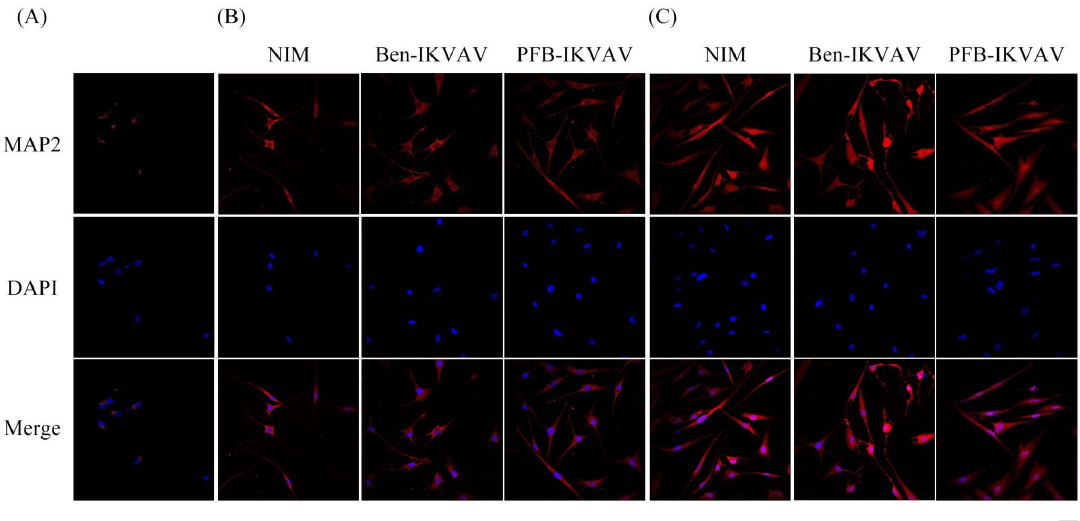
Figure 11. Representative images show immunofluorescent staining of MAP2 expression in hMSCs cultured with NIM (control), NIM in the presence of Ben-IKVAV, and NIM in the presence of PFB- IKVAV for ( A ) day 1, ( B ) day 2, and ( C ) day 7. Upper: cells appear red due to the presence of MAP2-Ab; middle: nuclei appear blue due to staining with DAPI; lower: merged image. (Scale bar: 20 μ m.).